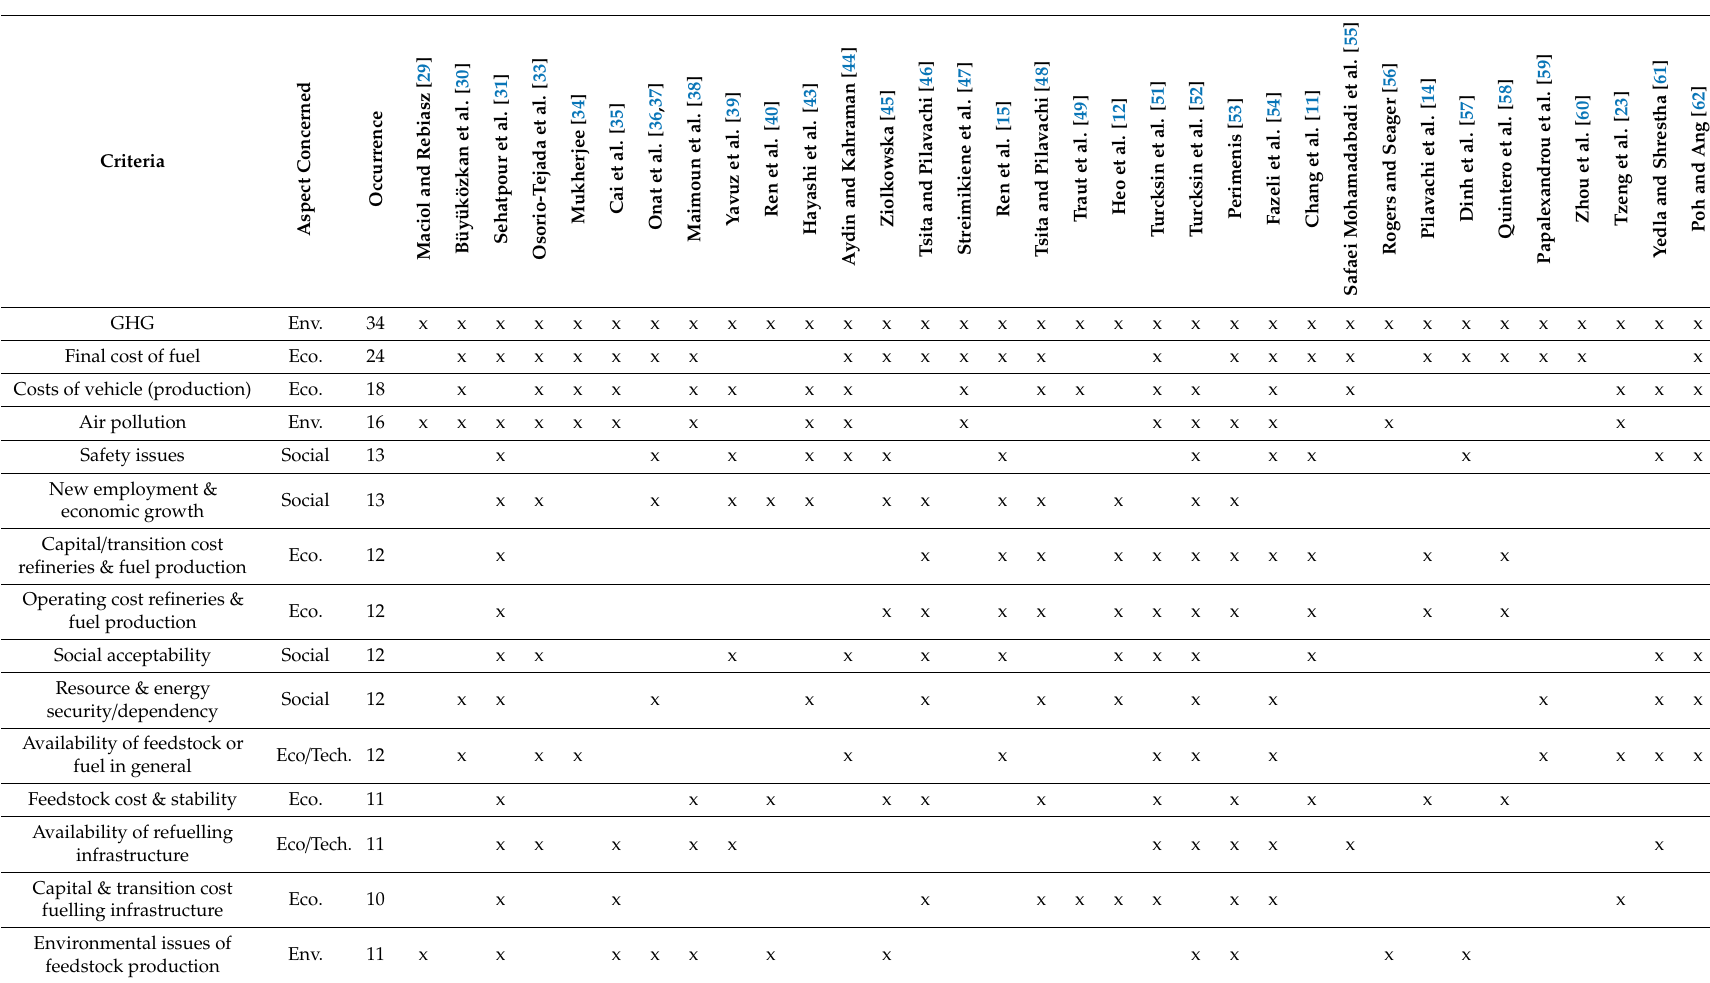
Table 8. Criteria listed by paper and